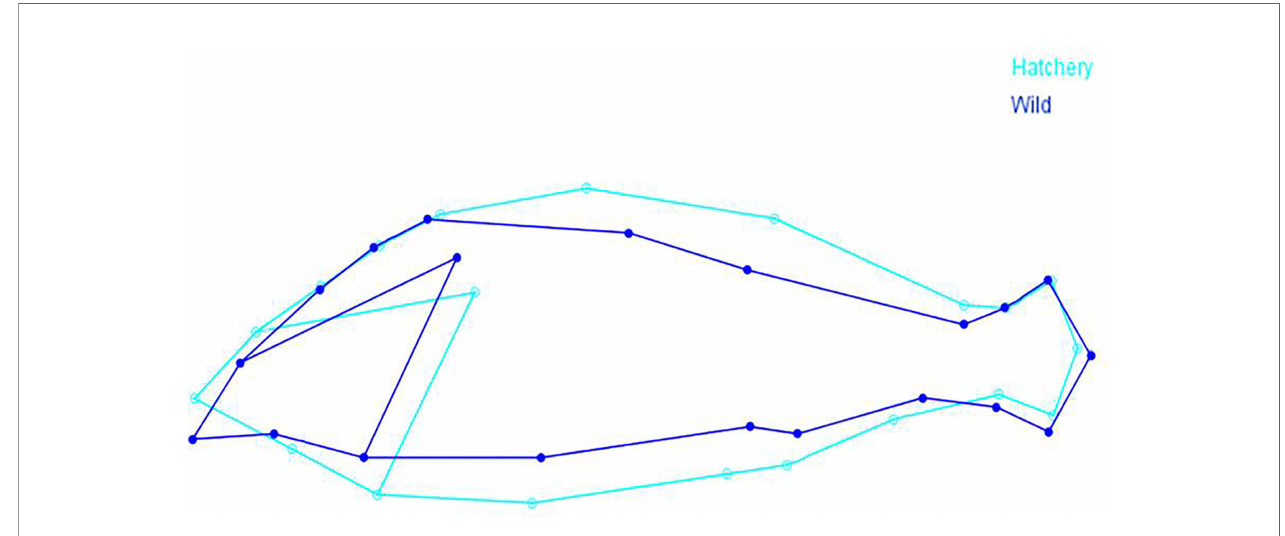
FIGURE 4 | Comparisons of mean shape between hatchery-reared and wild marbled rock fi sh. Points relate to landmarks in Figure 1 .